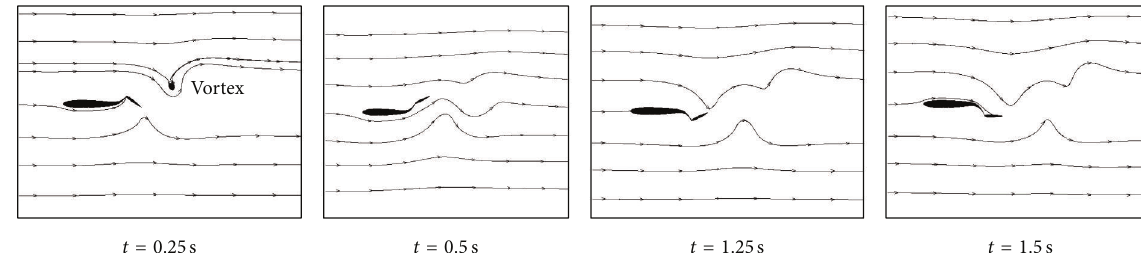
Figure 12: Trailing vortex at 𝜑 = 90 ∘